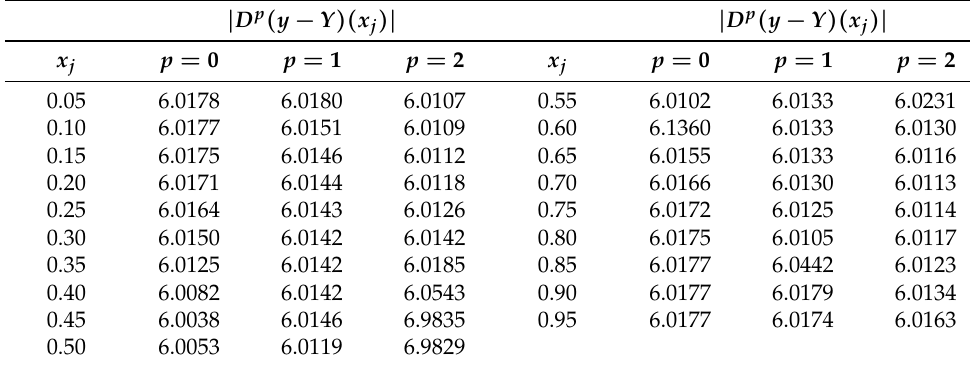
Table 1. Nodal convergence rates at the common nodes for Example 1.